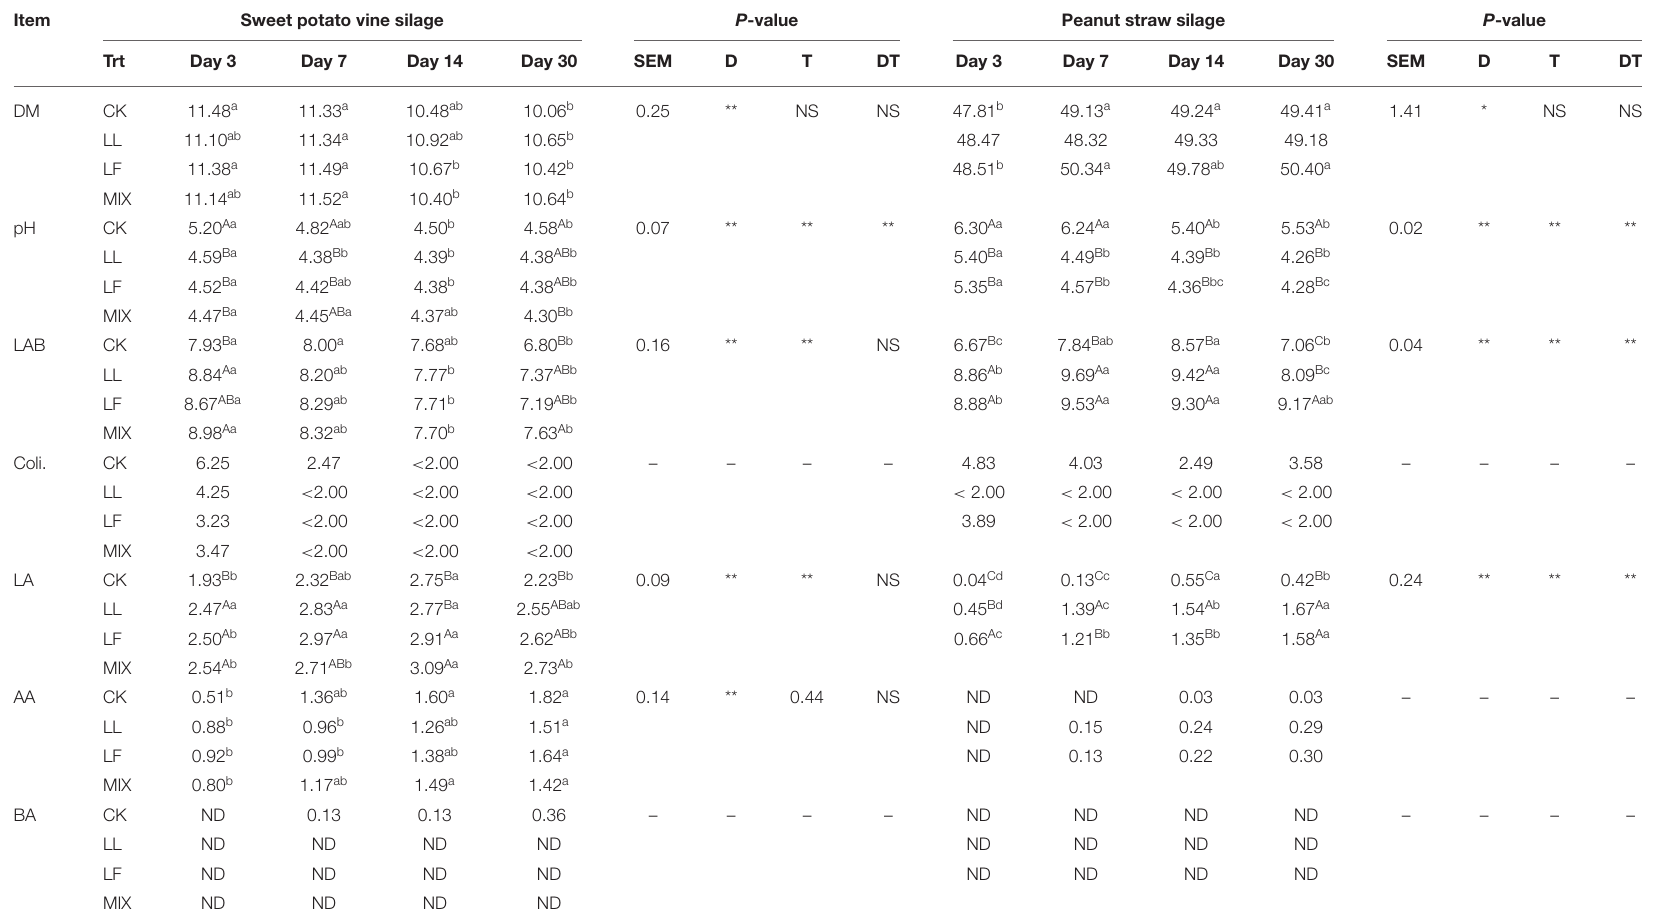
TABLE 2 | The effect of LAB inoculation on the fermentation characteristics of SPV and PS